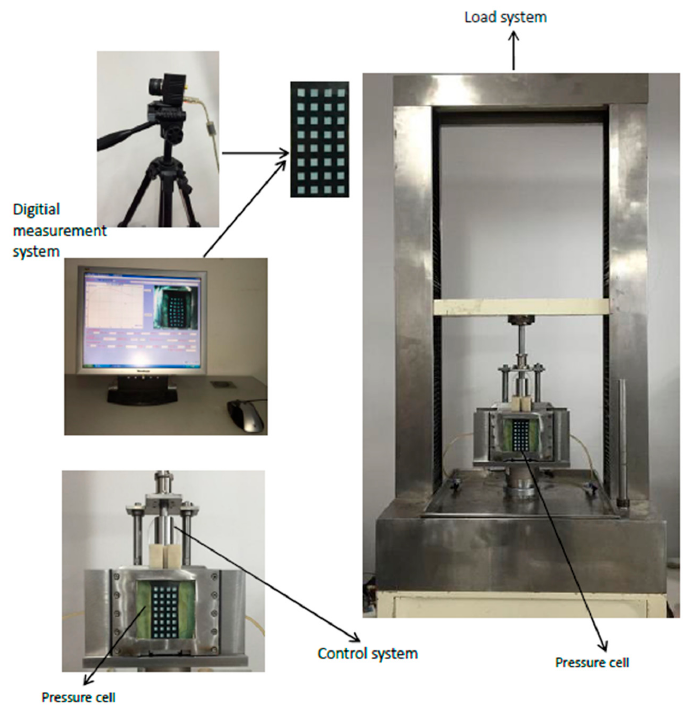
Figure 13. Plane strain apparatus.